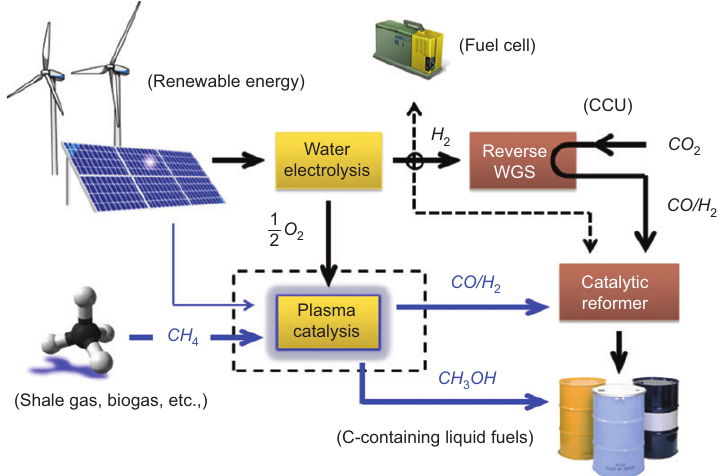
Figure 2 Concept of plasma enhanced C capture and utilization (CCU), and a catalytic fuel conversion system (material and energy balance is not considered in this schematic diagram).